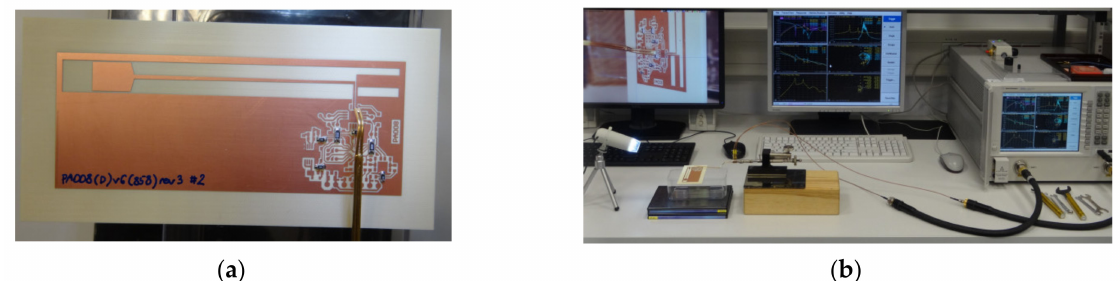
Figure 12. Design of RFID antenna with reflector under radiator: ( a ) Sample; ( b ) Measurement stand.